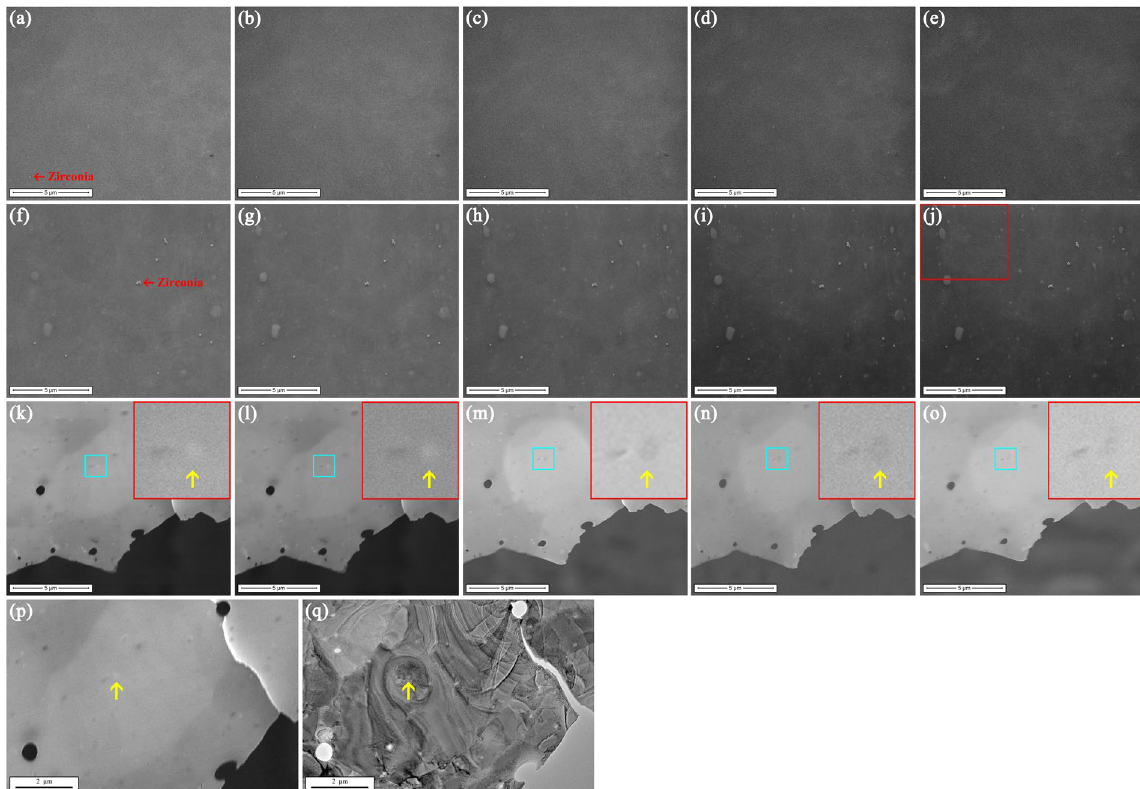
Figure 1. Surface morphology evolutions of pure Zr and Zircaloy-4 specimens under irradiation at room temperature with focused and stationary electron beam at an incident energy of 30 keV in the FE-SEM. ( a–e ) SEM images of the selected surface area of the polished bulk pure zirconium specimen after irradiation for 1, 8, 16, 24, and 32 electron beam scans, respectively. ( f – j ) SEM images of the selected surface area of the polished bulk Zircaloy-4 specimen after irradiation for 1, 8, 16, 24, and 32 electron beam scans, respectively. The clearly visible ball-shaped zirconia particles (red arrows in Fig. 1a and f) suspended on the surface indicate that the SEM images were taken when the surface was clearly focused. ( k – o ) SEM images of the selected thin film region in the vicinity of the hole of the Zircaloy-4 TEM specimen after irradiation for 1, 32, 64, 96, and 128 electron beam scans, respectively. The area outlined by a blue square in every image is expanded in its corresponding inset outlined by a red square, which shows the morphology of the precipitate of interest (yellow arrow in the inset). ( p , q ) SEM and TEM images showing that the electron beam irradiation in the FE-SEM and the microstructure observation in the TEM were performed on the same thin film region of the Zircaloy-4 TEM specimen containing the precipitate of interest (yellow arrows in Fig. 1p and